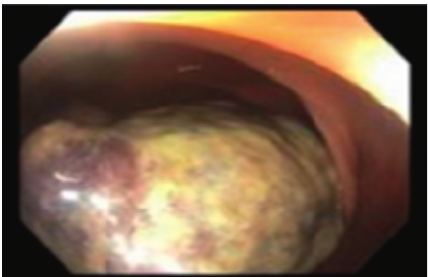
Figure 2: Images from colonoscopy demonstrating pedunculated large mass in the cecum.